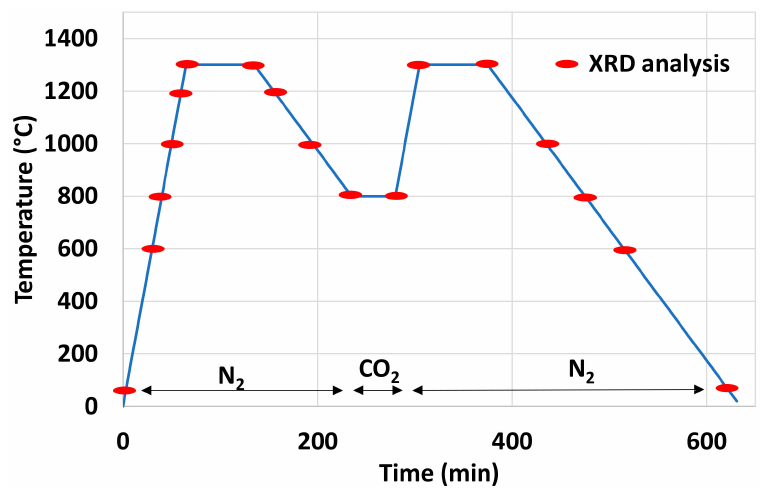
Figure 14. Temperature profile for XRD in situ